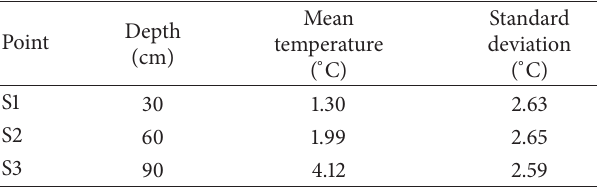
Figure 3: Soil temperatures at the study site for depths of 30, 60, and 90 cm from November 11, 2011, to February 14, 2012. Table 1: Summary statistics for temperature measurements from the study site. S1, S2, and S3 indicate the three soil depths at which measurements were